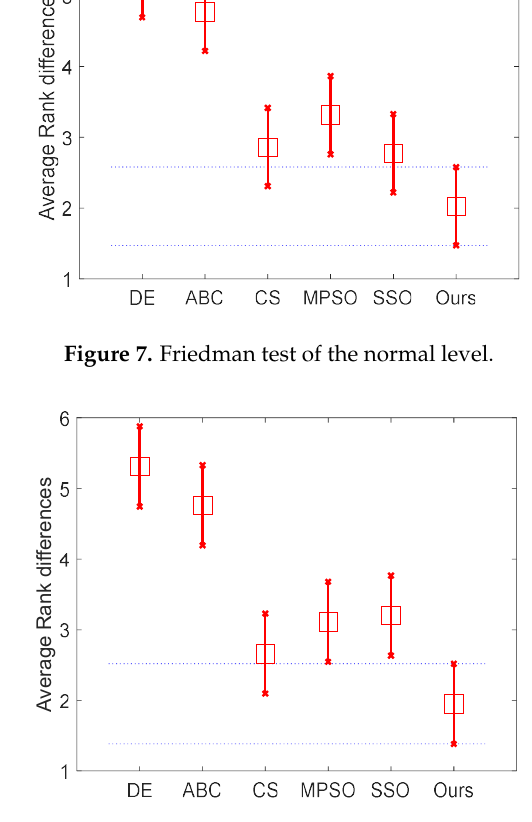
Figure 8. Friedman test of the high level.